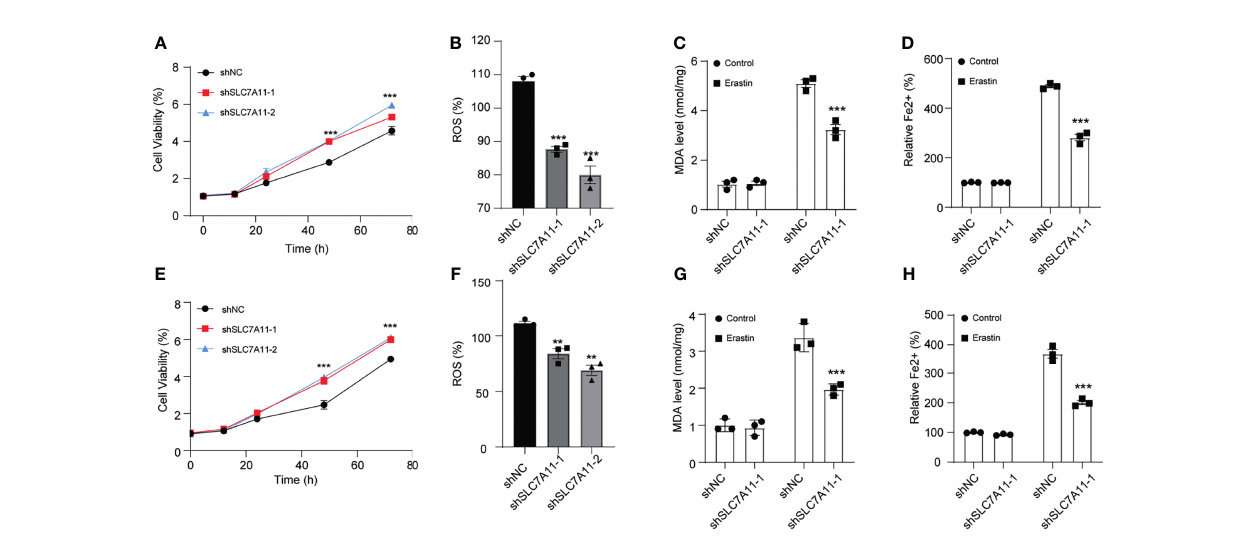
FIGURE 3 | SLC7A11 modulates ferroptosis induced by erastin in NSCLC cells. (A) Determination of the viability in SLC7A11 knockdown A549 cells with erastin (5 µM) treatment for 24 h. The intercellular ROS (B) , MDA (C) , and Fe 2+ levels (D) were signi fi cantly suppressed abrogated on SLC7A11 knockdown cells. (E) Cell viability of SLC7A11 knockdown Calu-3 cells with erastin (5 µM) treatment for 24 h. The intercellular ROS (F) , MDA (G) , and Fe 2+ levels (H) were signi fi cantly suppressed abrogated on SLC7A11 knockdown cells. **P < 0.01 and ***P < 0.001